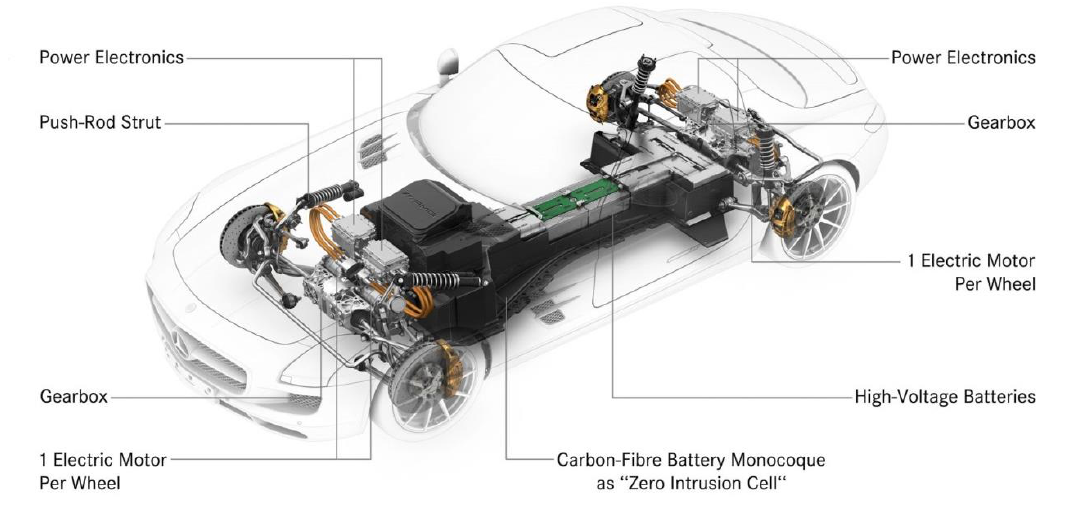
Fig. 10. Mercedes-Benz SLS AMG Electric Drive – powertrain overview